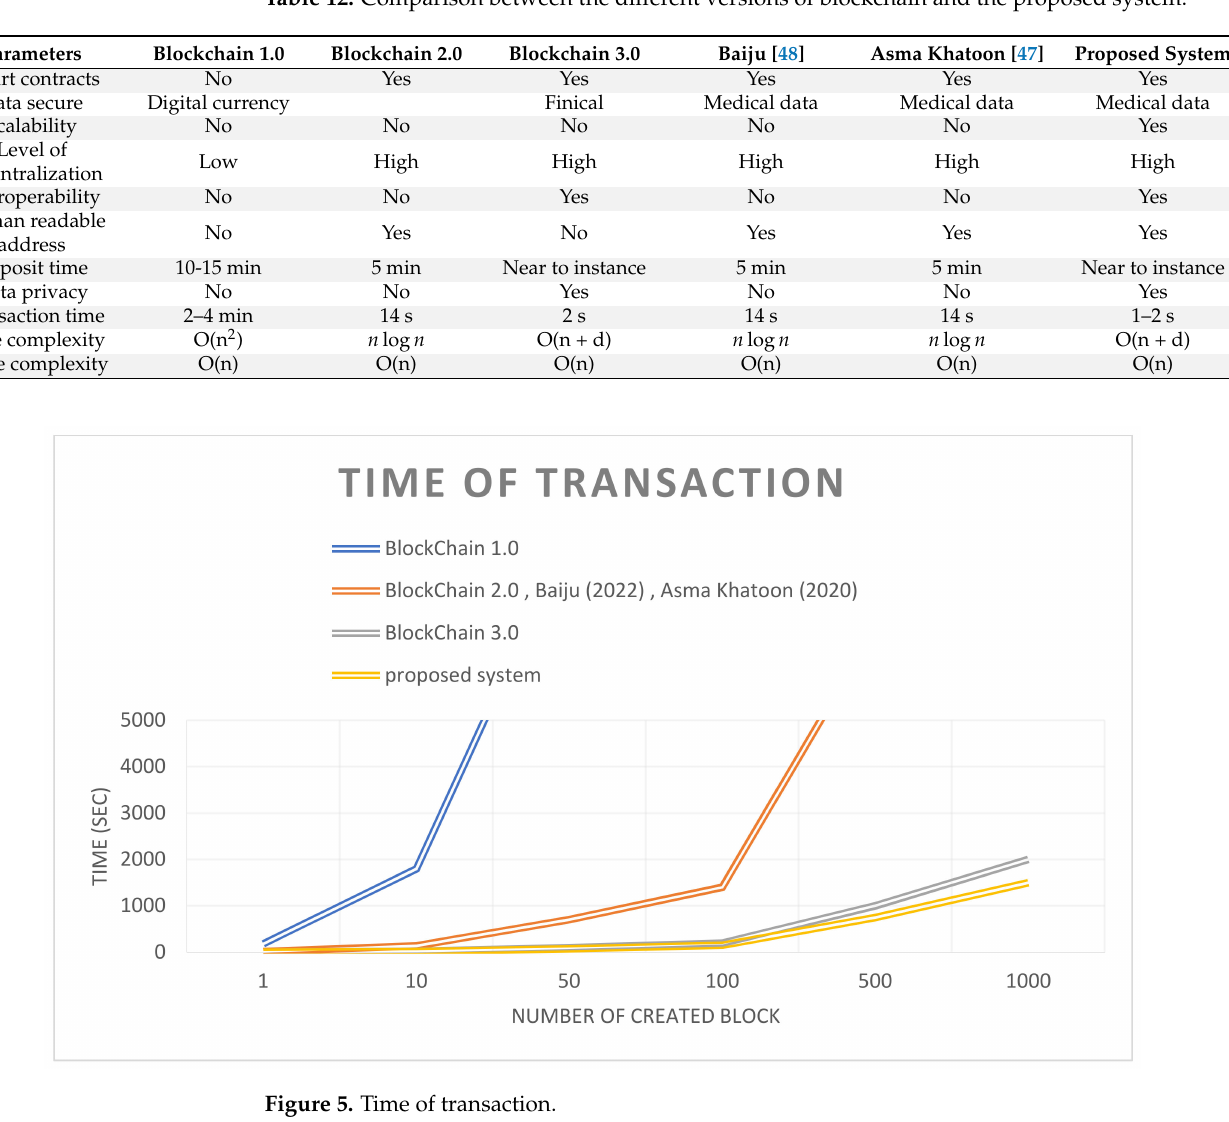
Table 12. Comparison between the different versions of blockchain and the proposed system.